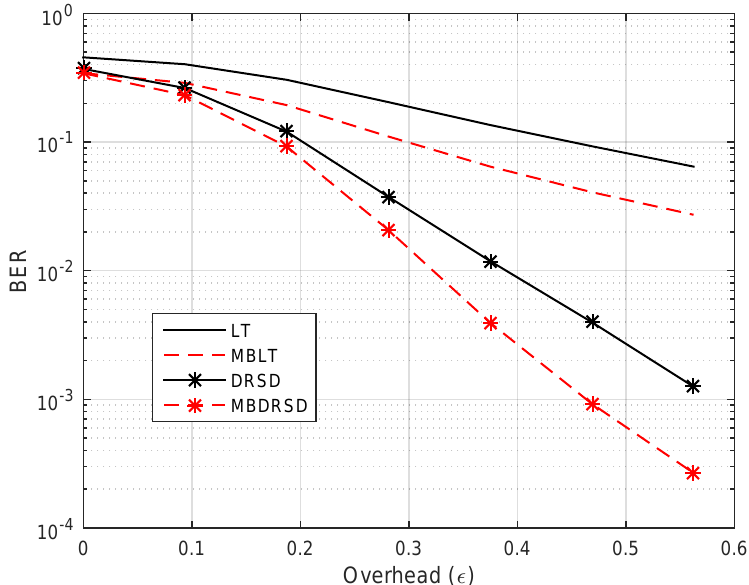
Figure 7. Bit error rate (BER) versus the overhead ( (cid:101) ) for different coding schemes at k = 128 and erasure probabilities of ε 1 = 0, ε 2 = 0, and ε 3 = 0.